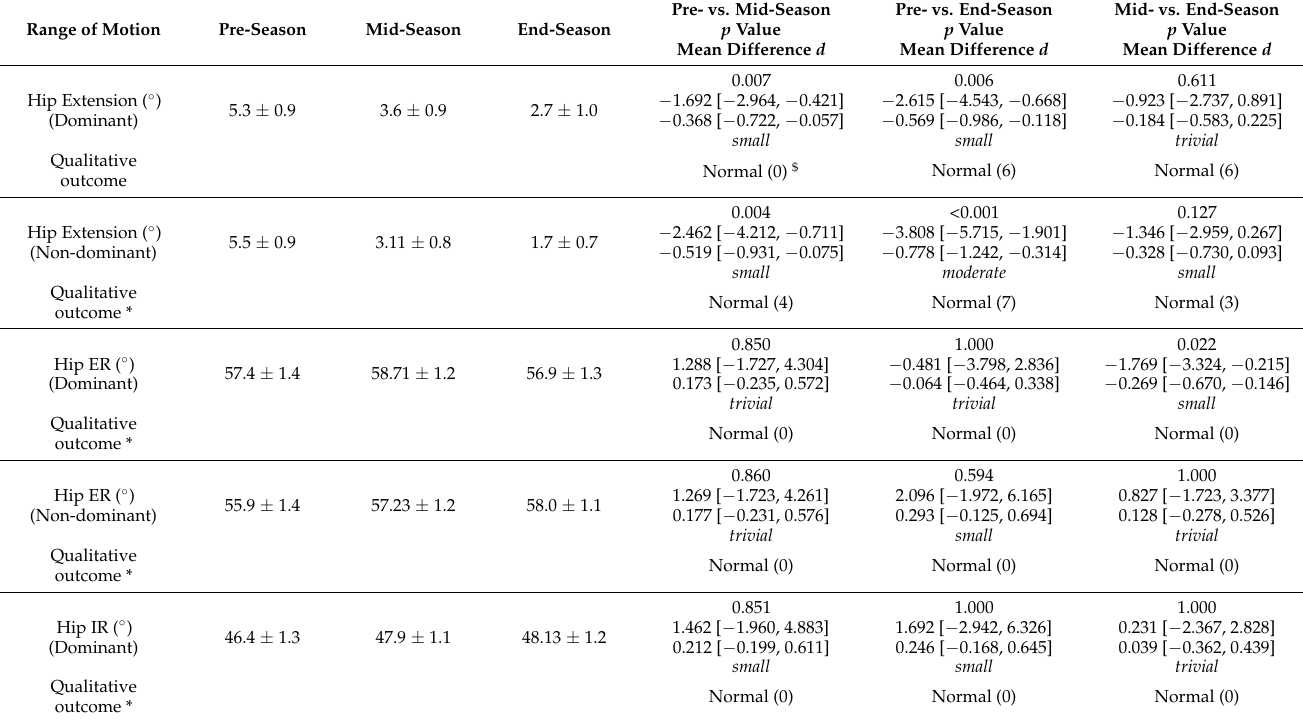
Table 2. Hip extension, external rotation, internal rotation, flexion, and ankle dorsiflexion ROM assessed at pre-season, mid-season, and